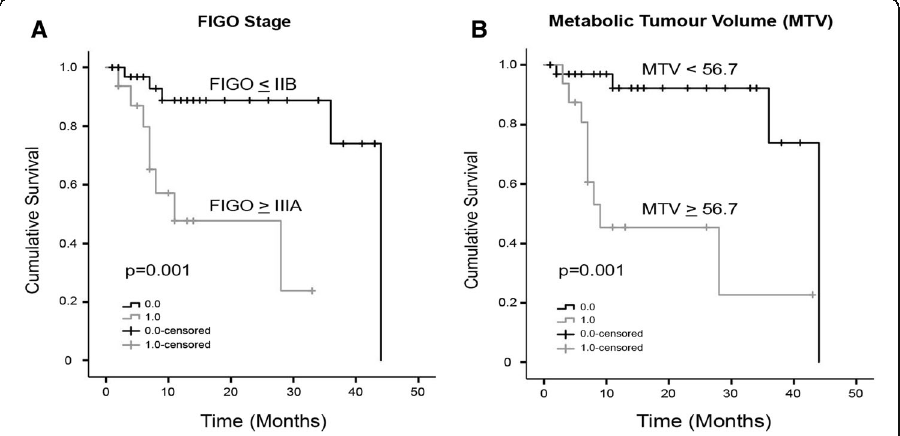
Fig. 4 Kaplan-Meier survival curves of progression/recurrence according to FIGO stage ( a ) and MTV 56.7 ( b